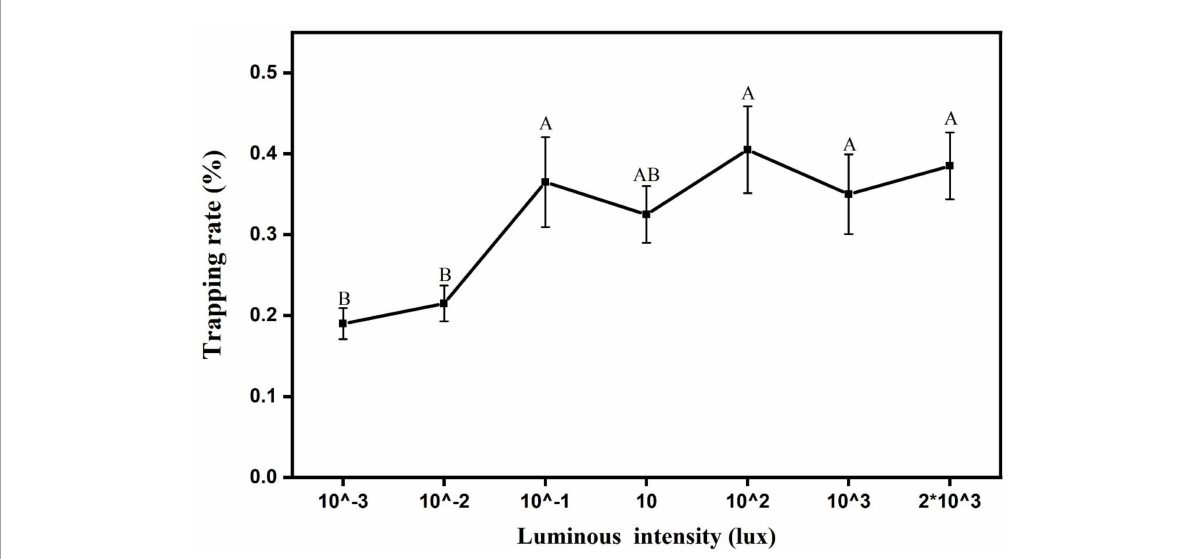
FIGURE9 Trapping rate of L. striatellus s at different light intensities. Each value represents the trapping rate T 1 of the adult L. striatellus for that light intensity, and the error bars represent the standard error. Different letters above each group of data indicate significant differences between treatments ( p < 0.01).